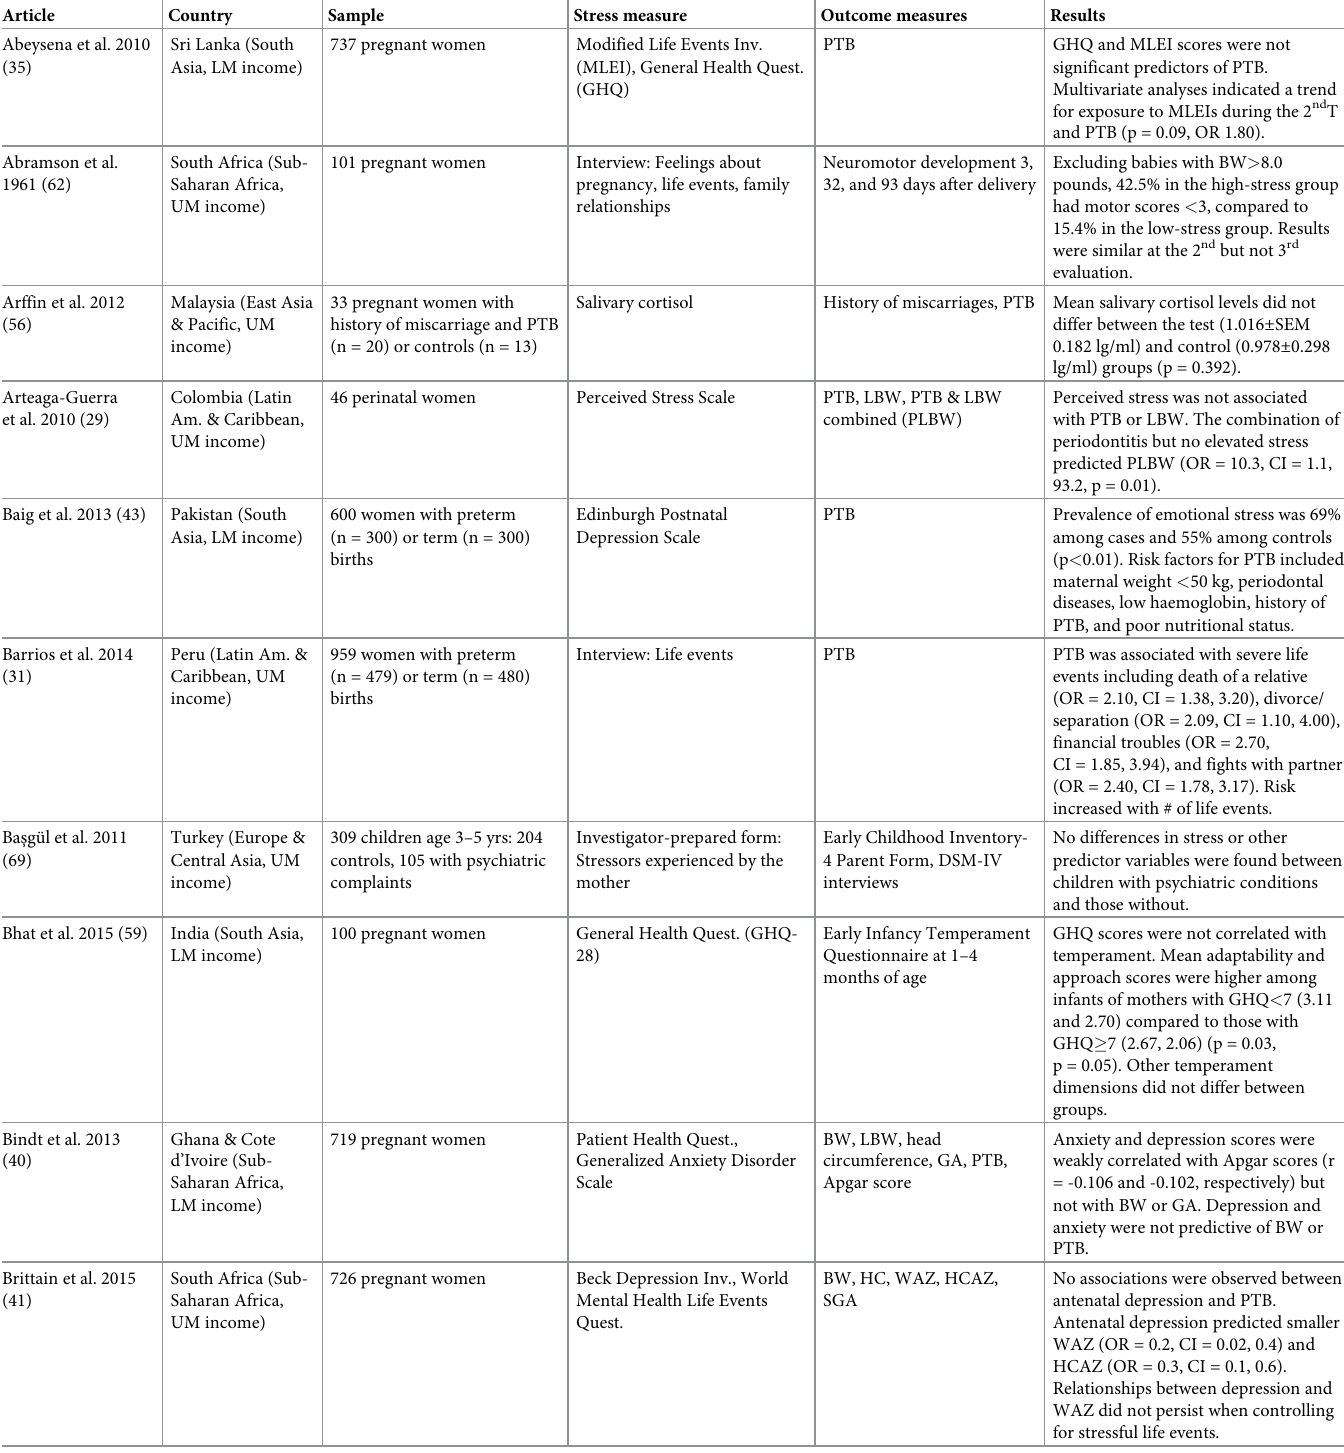
Table 1. Summary of studies of prenatal stress and pregnancy and child health outcomes in